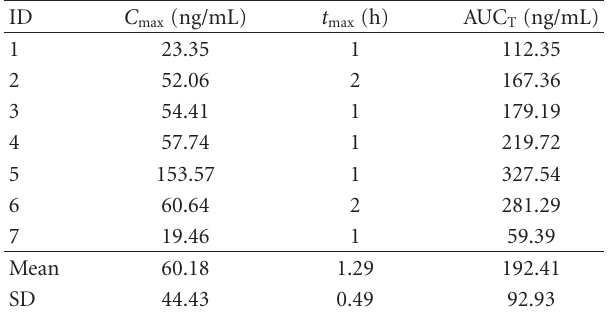
Table 2: Parameter estimates for each subject who underwent pharmacokinetic testing at 1, 2, 4, and 8 hours.